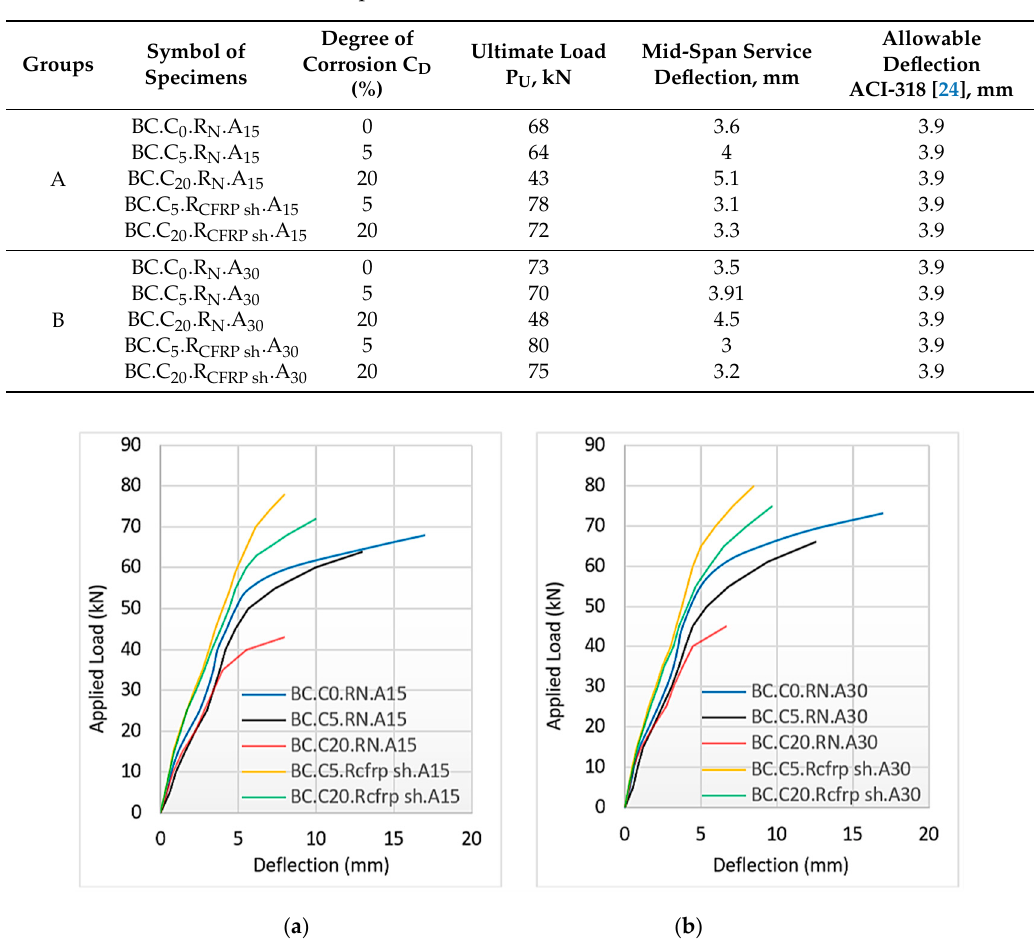
Figure 5. Comparison of load deflection response for each group. ( a ) Group A; ( b ) Group B.